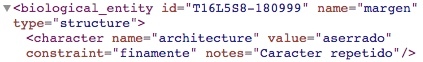
Structured text that exemplifies the use of adverbs in the chunk T16L5S8.